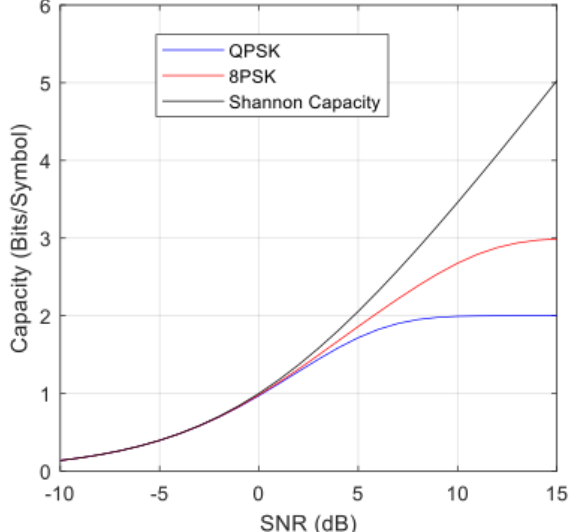
Figure 3. Numerically integration of constrained capacity for QPSK and 8 -PSK, and Shannon